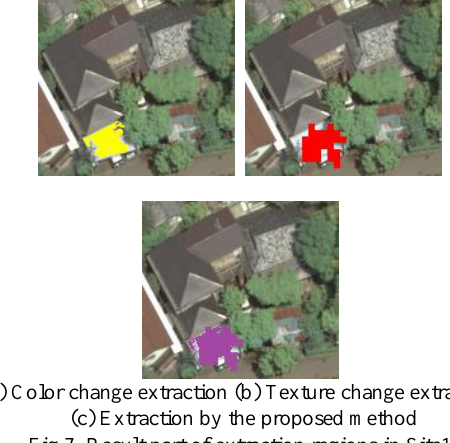
Fig.7. Result part of extraction regions in Site1